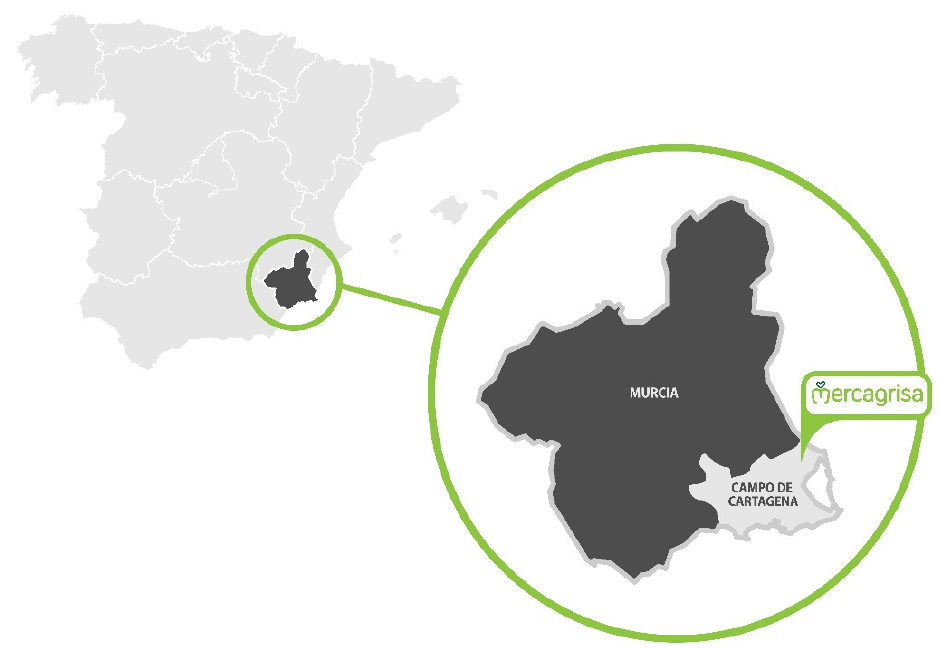
Figure 1. Geographic location of Campo de Cartagena and MERCAGRISA.